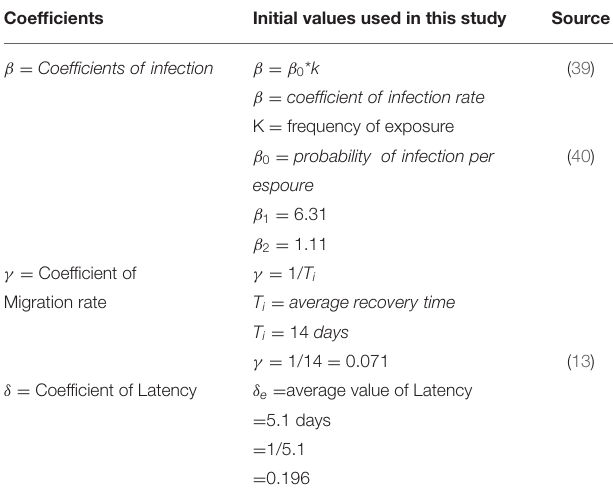
TABLE 3 | The results of SEIRV coefficients and